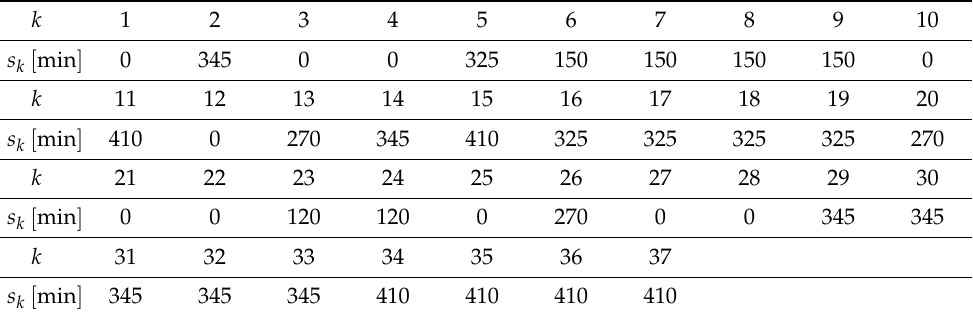
Table 12. Initial values of the constant s k .